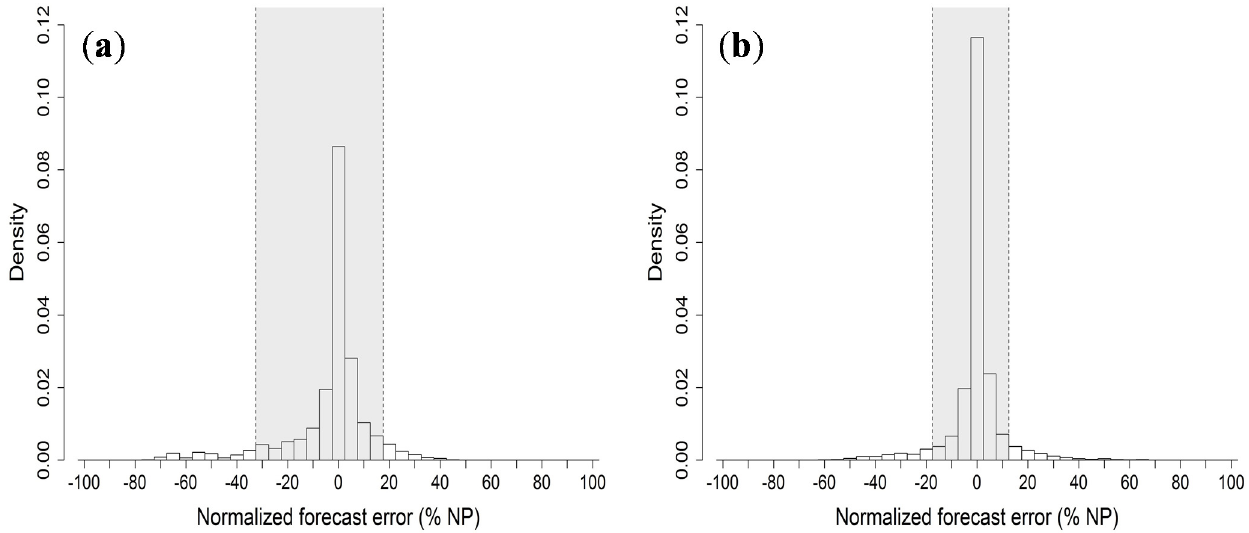
Figure 9. Error distributions (id07) of the best forecasts for the Milano case ( a ) and the Catania case ( b ). The grey area in each histogram delimits the 5%–95% quantiles